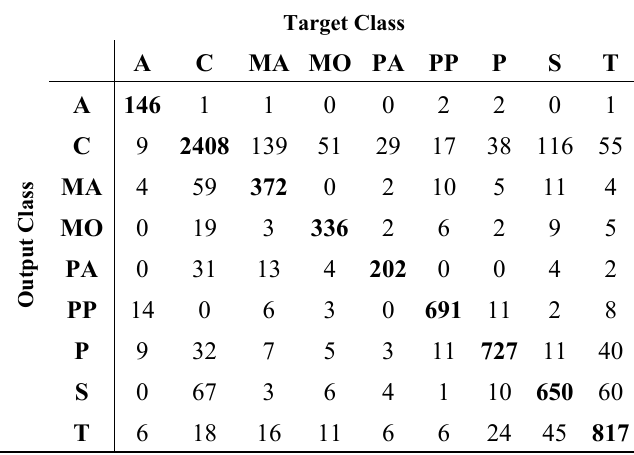
Table 9. The error matrix of our proposed method tested on the MLC 2008 dataset. The classes in both row and columns corresponds to A = Acropora , C = CCA, MA = Macroalgae, the main 9 × 9 cell portion of the table, the given number corresponds to the raw count of the number of validation image patches that fell into a particular target/output